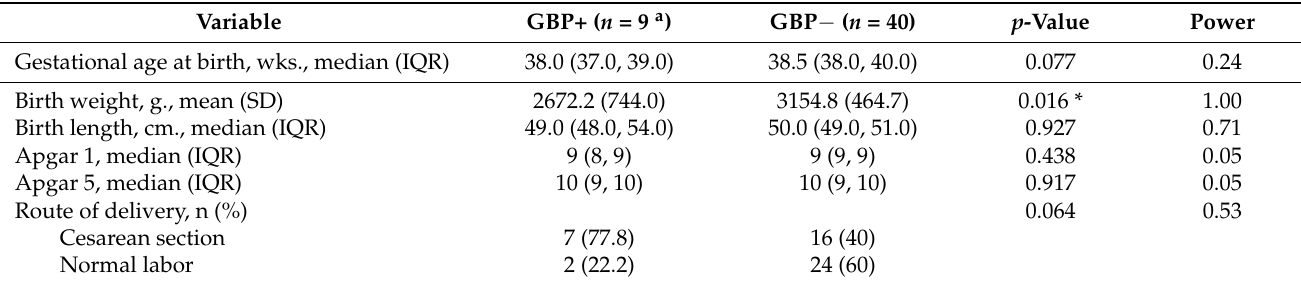
Table 2. Comparison of neonatal health characteristics between the newborns of pregnant women with and without gestational Bell’s palsy (GBP+ and GBP − ) by bivariate analysis.